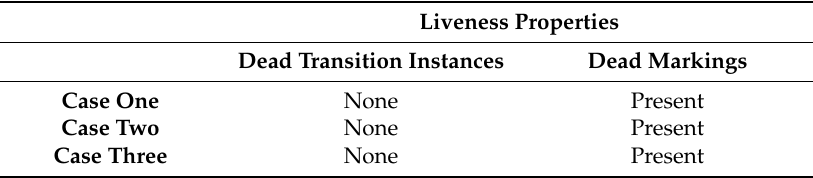
Table 8. Part of State Space